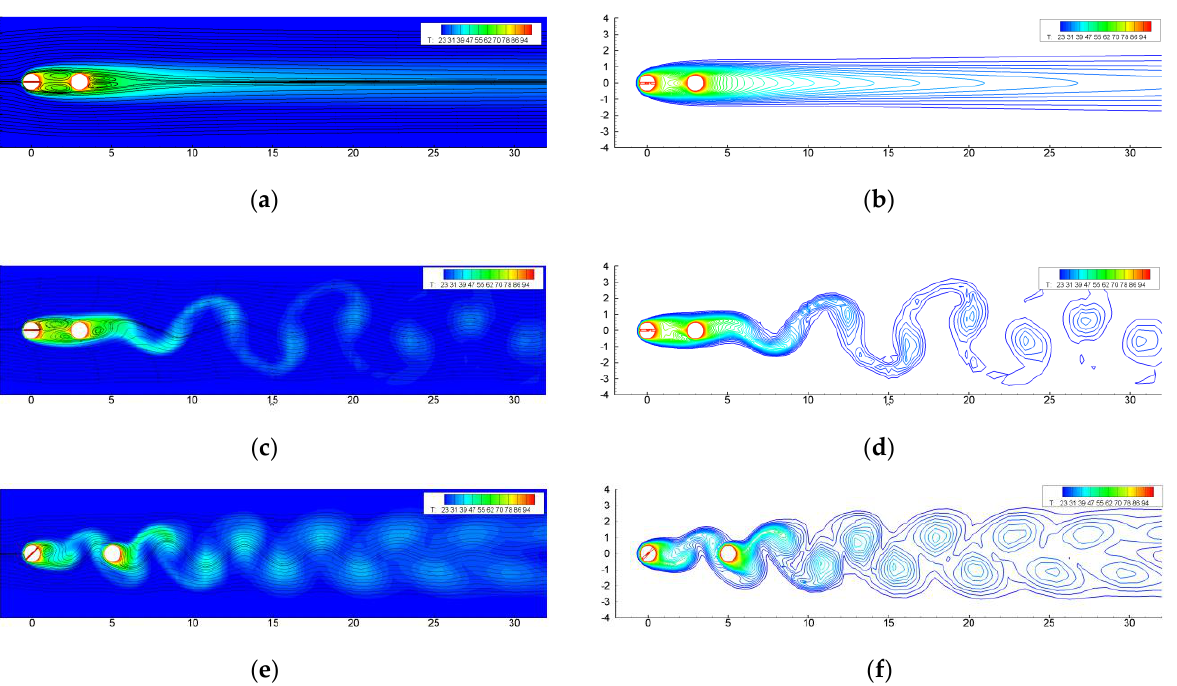
Figure 14. The history of drag and lift coefficients for Re = 200, L/D = 7: ( a ) drag coefficient; ( b ) lift coefficient.